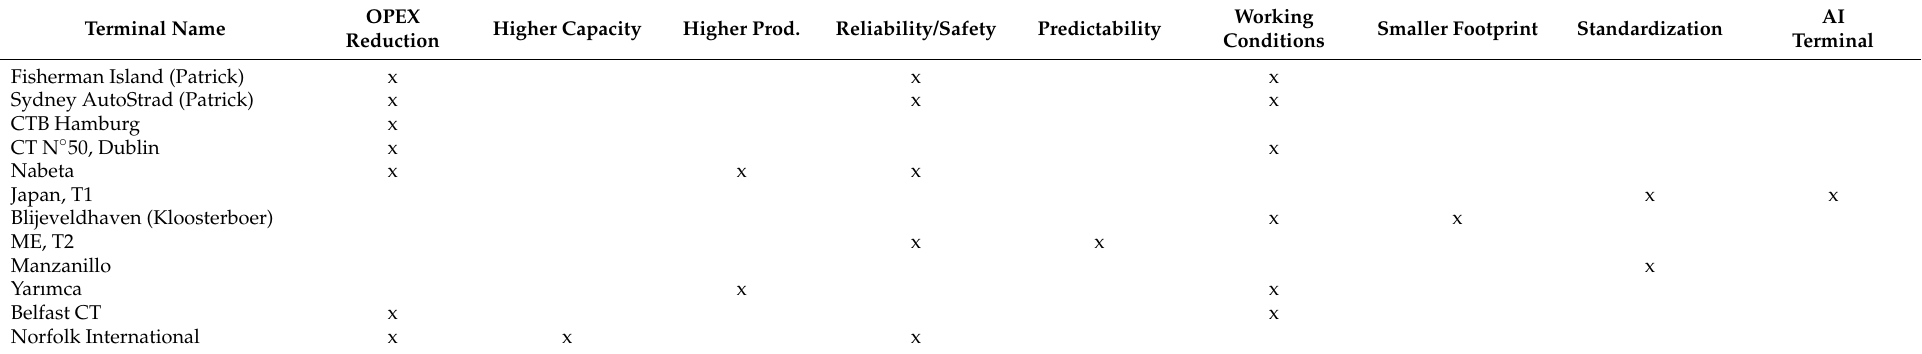
Table A5. Benefits from automation identified from questionnaire responses.